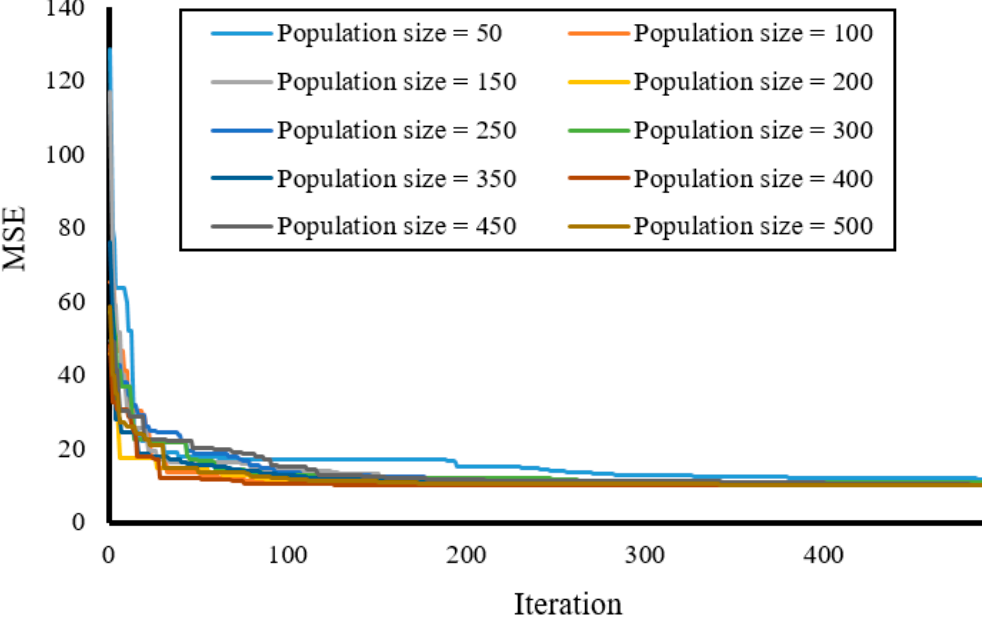
Figure 9. The sensitivity analysis for GA-ANN, based on the number of hidden neurons.